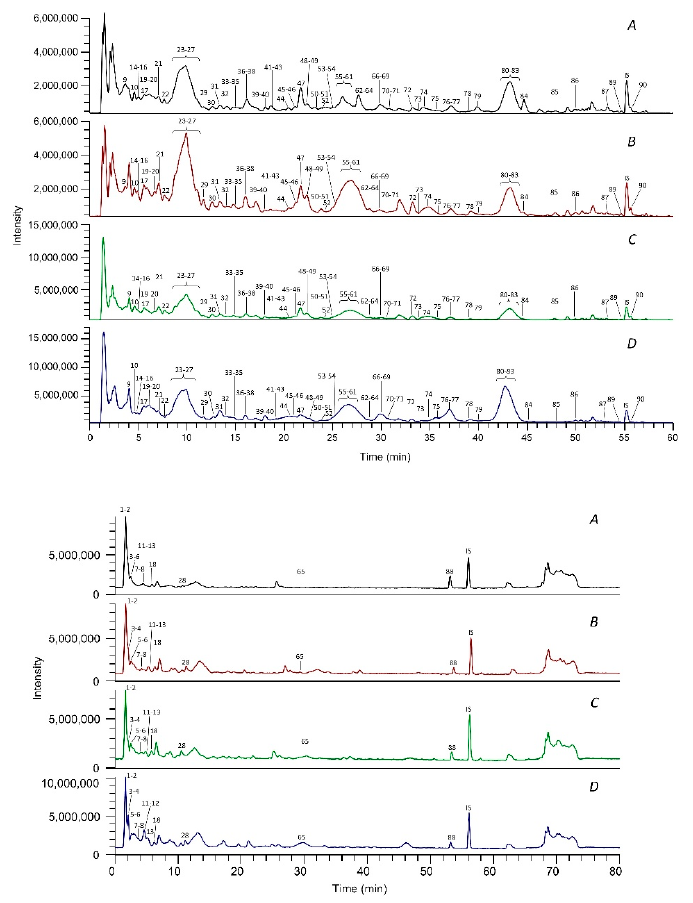
Figure 1. TIC chromatograms of the four commercial enocianinas recorded in positive ( top ) and negative ( bottom ) ion modes. Identified peaks are numbered progressively, according to the elution order, and the assignment of each peak is reported in Supplementary Table S1.